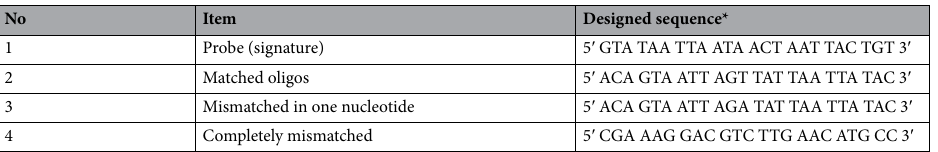
Table 1. Sequences of the designed oligos used for the construction of the SARS-CoV-2 RNA biosensor. *The designed primers were provided by Introgen Co., USA. The mismatched oligo in one nucleotide (Thiamine nucleotide of the target Oligo replaced by Adenine in the mismatched